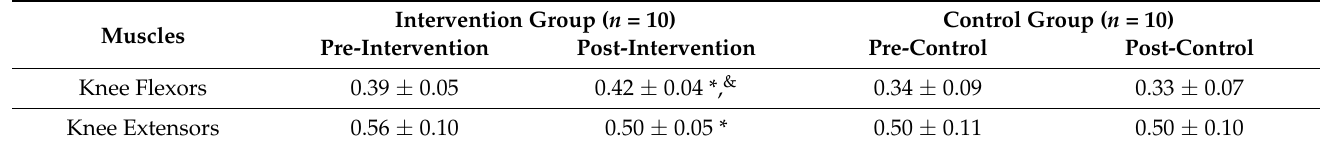
Table 2. Relative Lower Extremity Strength